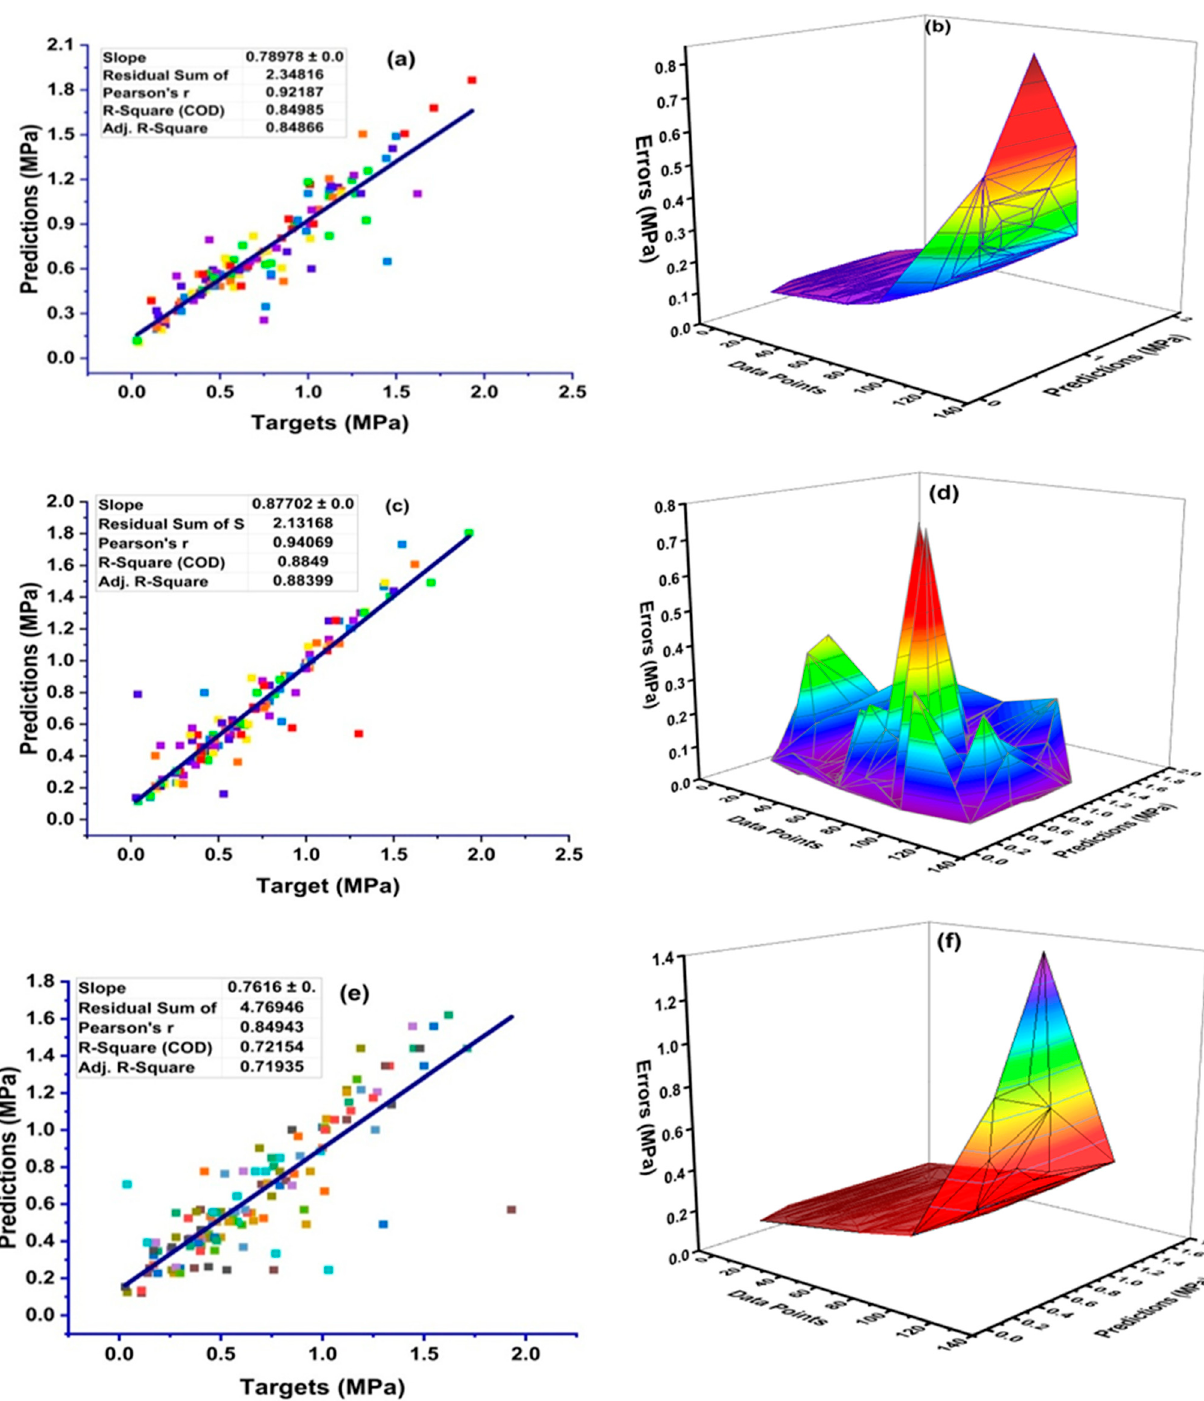
Figure 7. The results of the numerical analyses, which present the relationship between the predicted variable and the experimentally determined variable, as well as the distribution of errors for the ANN ( a , b ); GEP ( c , d ); and DT ( e , f ).